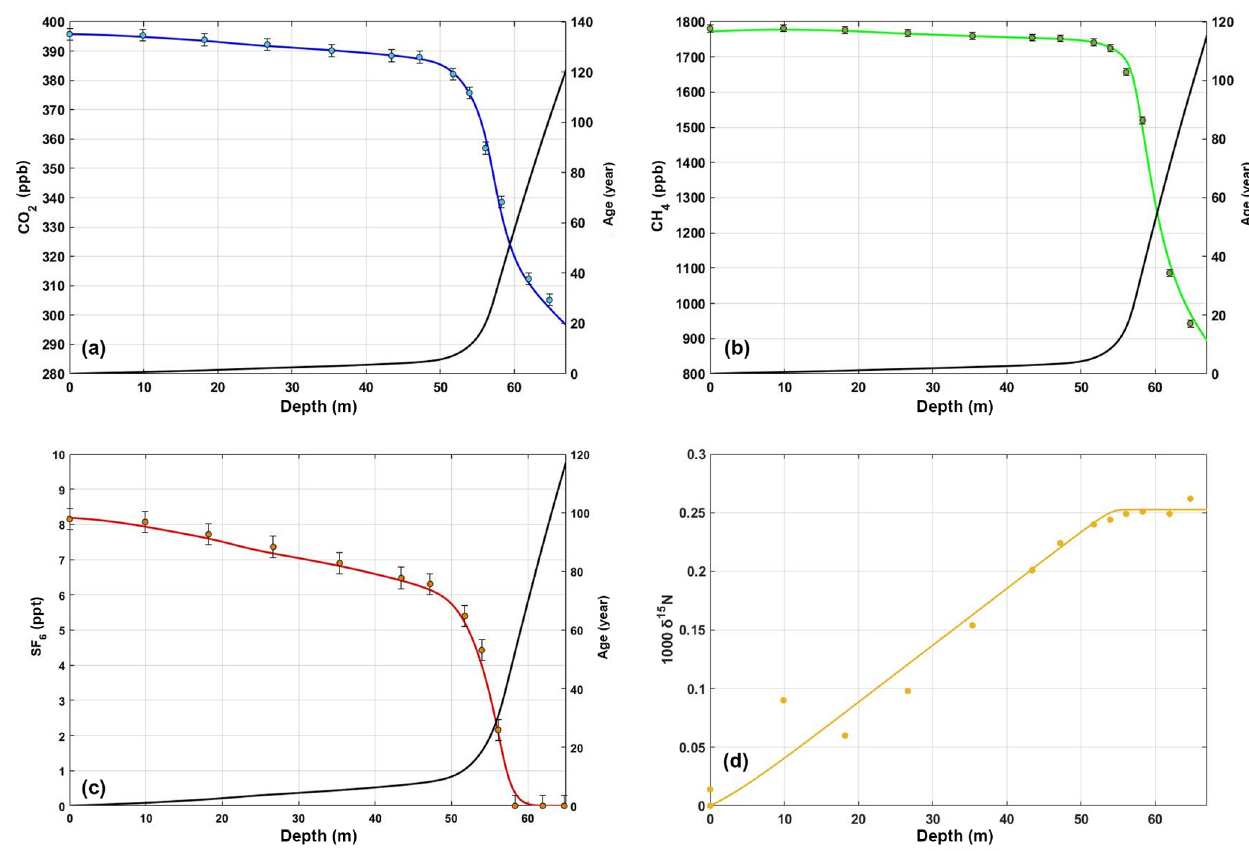
Figure 3. CO 2 , CH 4 , and SF 6 mole fractions and δ 15 N of N 2 measurements (circles), as well as model results (solid line) for the Styx firn air (air in open porosity). Black lines are modeled ages for the gas species.